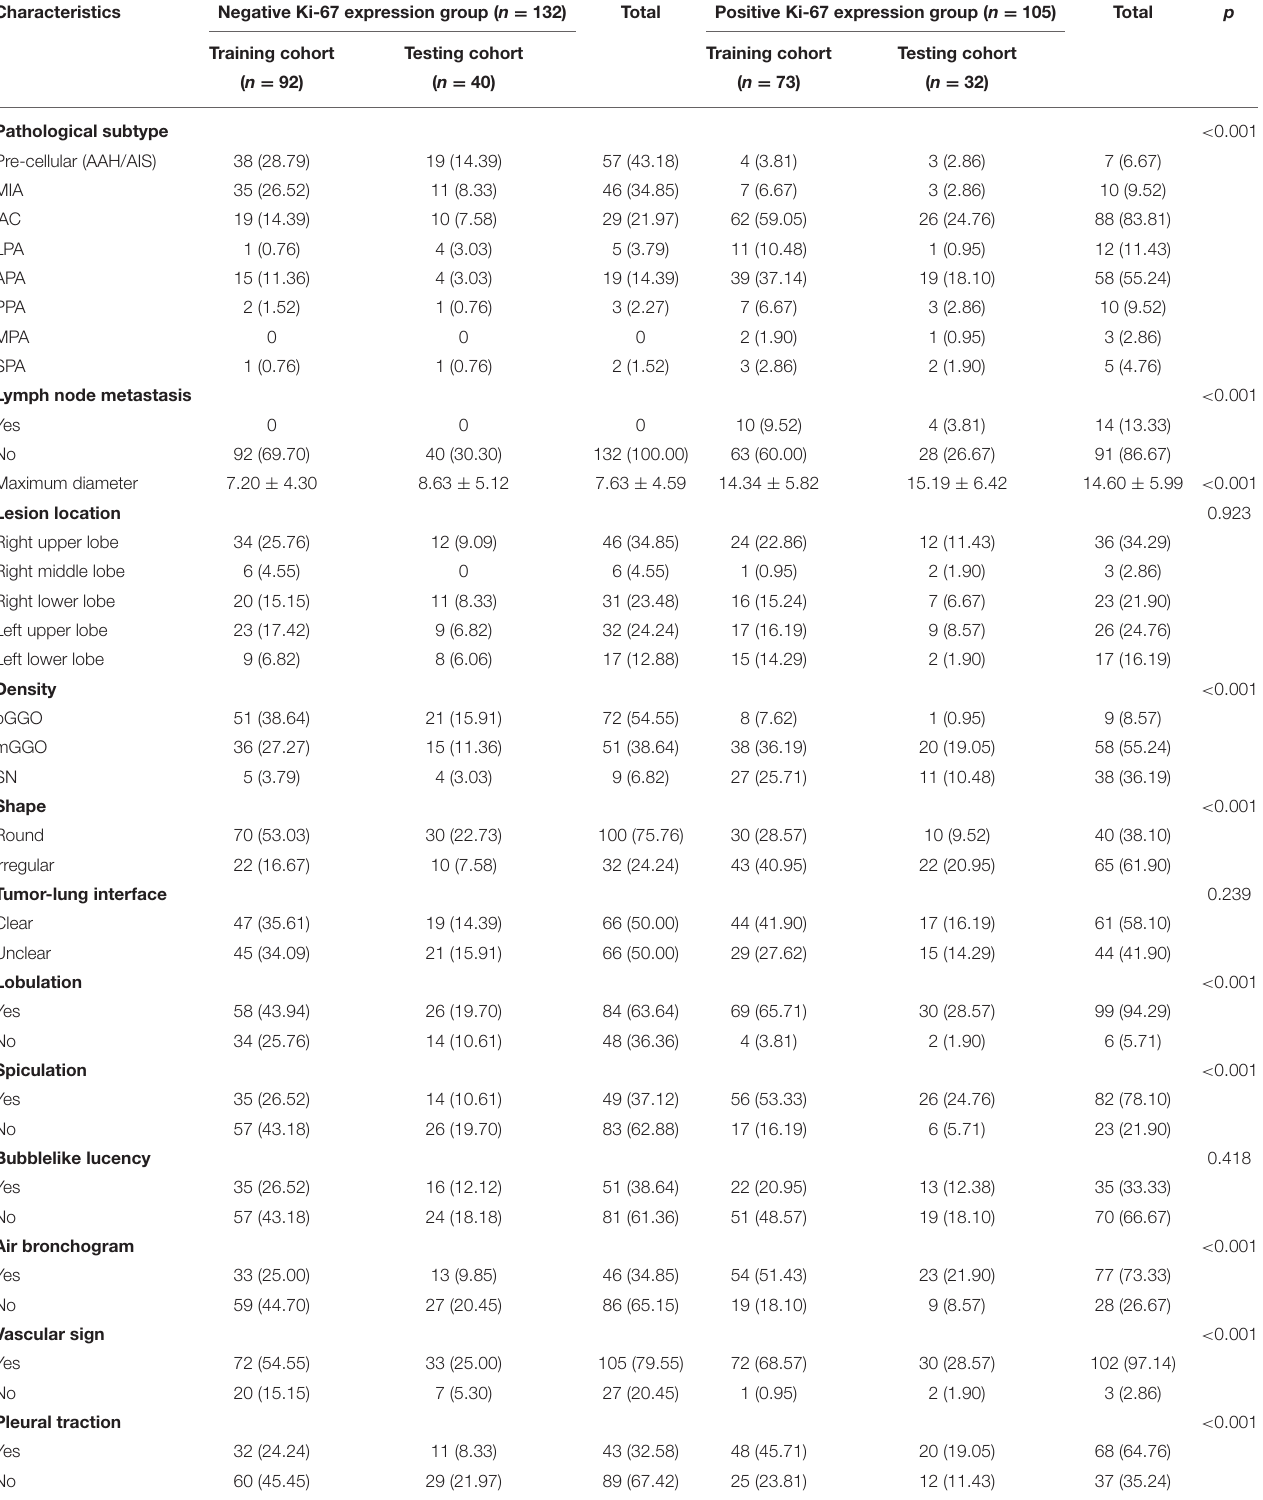
TABLE 4 | Comparison of imaging features and histopathological subtypes in the Ki-67 negative and positive expression groups of lung adenocarcinoma. Characteristics Negative Ki-67 expression group ( n = 132) Total Positive Ki-67 expression group ( n =